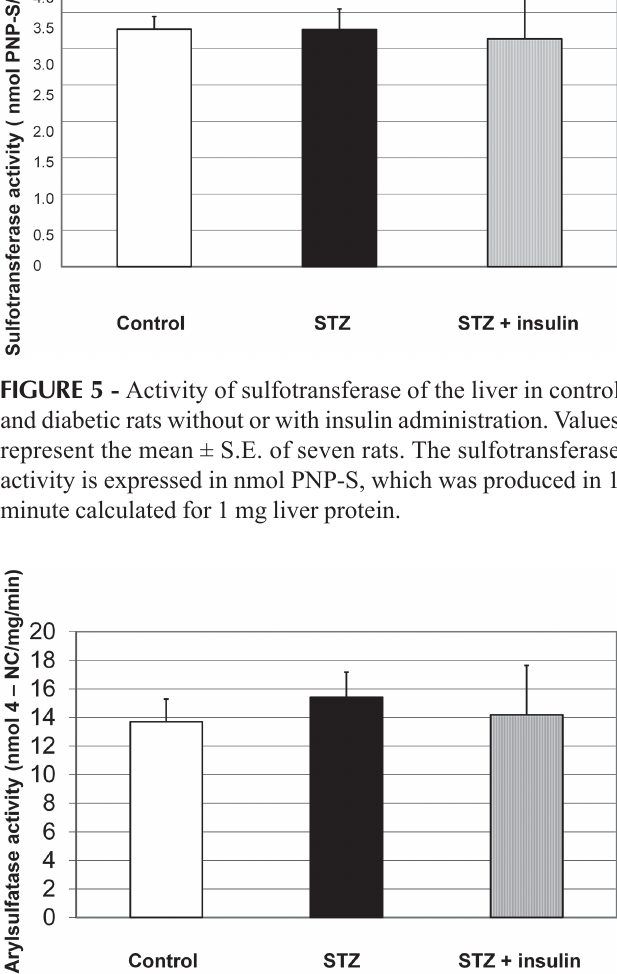
FIGURE 6 - Activity of arylsulfatase of the liver in control and diabetic rats without or with insulin administration. Values represent the mean ± S.E. of seven rats. Data expressed in nmol of 4-nitrocatechol (4-NC), which was produced from 4-NC sulfate in 1 minute calculated for 1 mg liver protein.